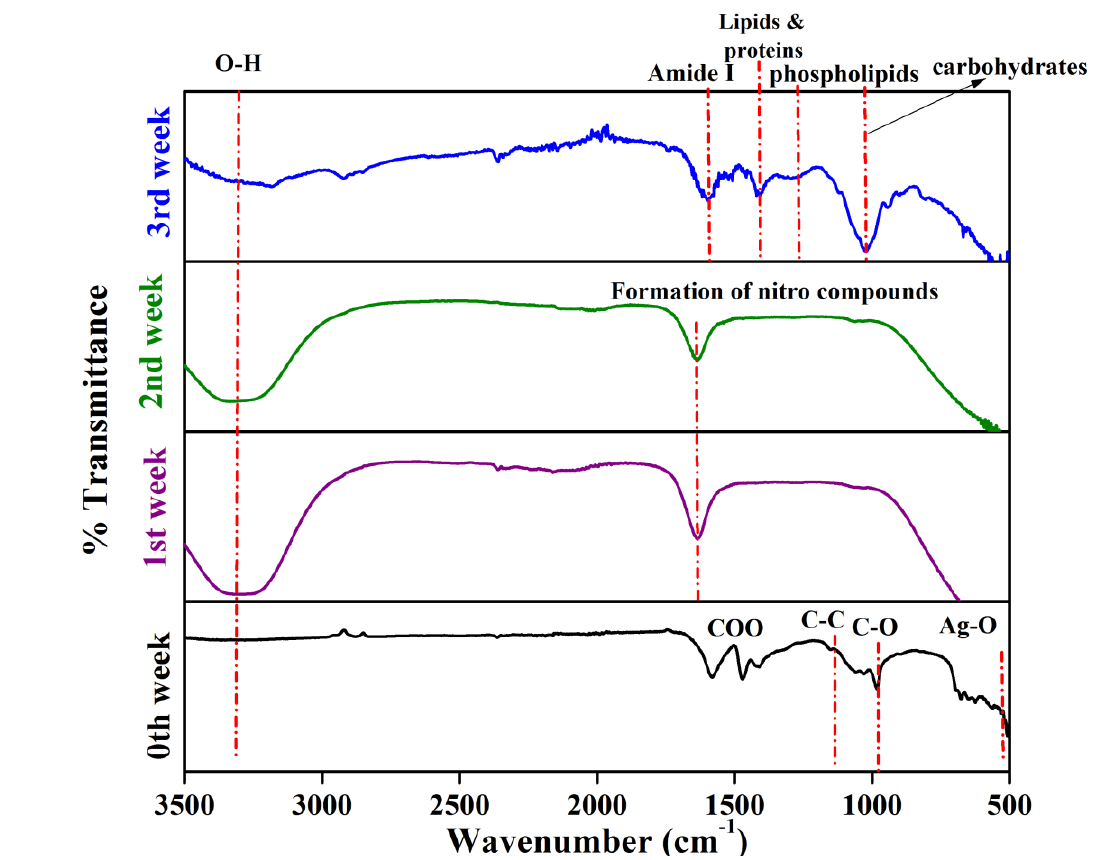
Figure 6. FTIR analysis of Ag coated